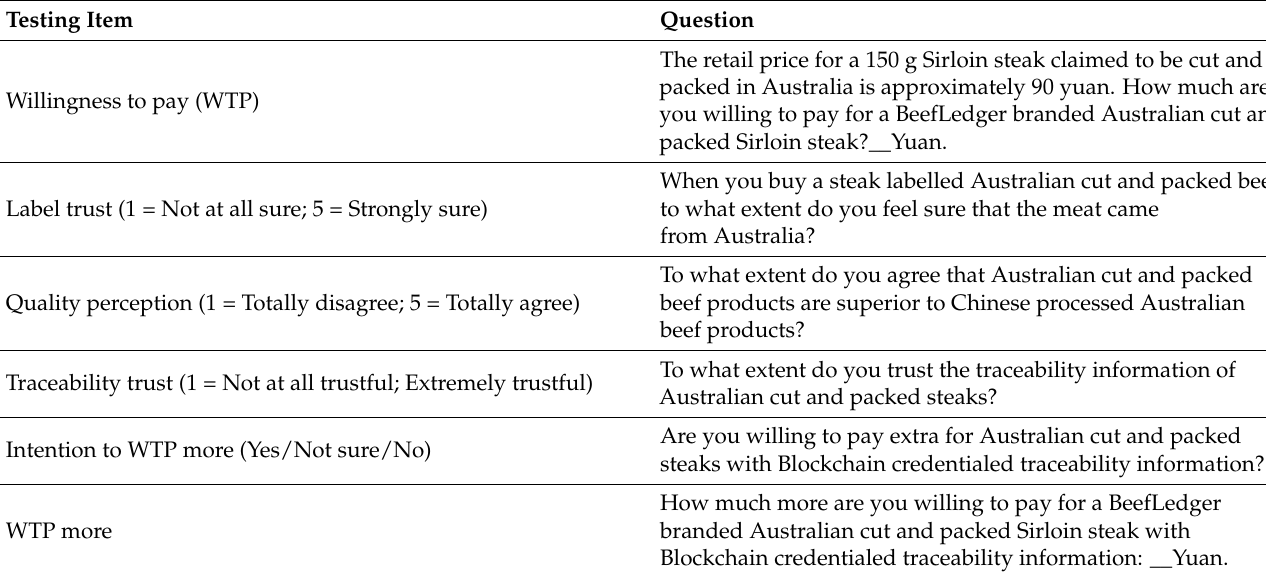
Table 1. Testing items and experiment question